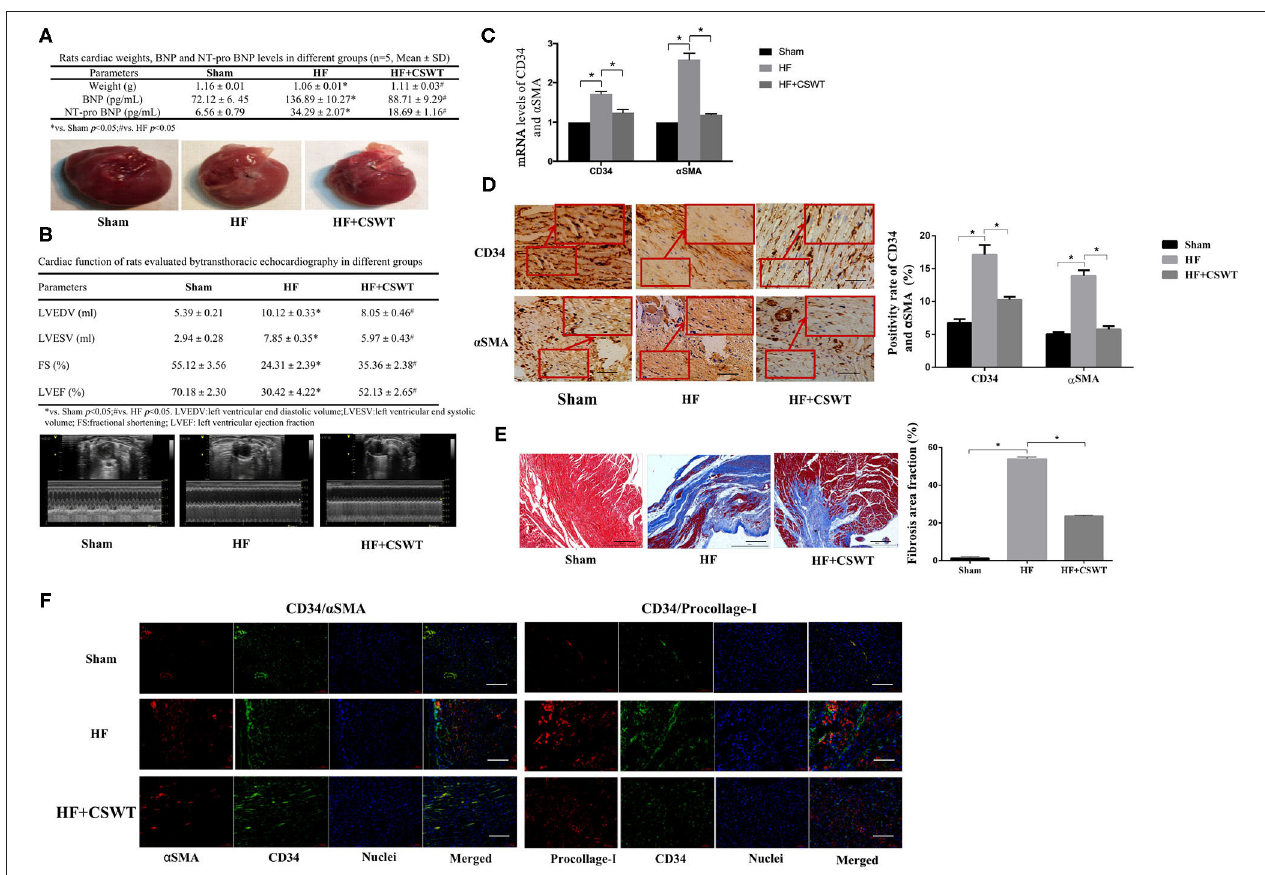
FIGURE 1 | CSWT improves cardiac functions and reduced fibrosis in rats with post-AMI HF. (A) The cardiac weight, serum levels of BNP and NT-pro BNP and gross view of whole hearts in study groups; (B) Representative M-mode images by echocardiography of rats in study group; (C) Fold changes in CD34 and α SMA mRNA levels determined by RT-PCR in study groups; (D) The positive rates of CD34 and α SMA in study groups using Immunochemistry analyses; scale bar, 100 µ m; (E) Representative images of Masson’s trichrome staining and quantification for fibrosis of rat hearts from each group; scale bar, 100 µ m; (F) Representative photomicrographs of immnunofluorescence for the detection of CD34/ α SMA and CD34/Procollage-I. Red fluorescence shows α SMA or Procollage-I expression. Green fluorescence shows CD34 expression. Blue fluorescence shows nuclei of total cardiomyocytes; scale bar, 50 µ m. Values are expressed as mean ± S.E.M ( n = 5). One-way ANOVA test was applied for determining the significance of data. * p < 0.05. CSWT, cardiac shock wave therapy; AMI, acute myocardial infarction; HF, heart failure; S.E.M, standard error of